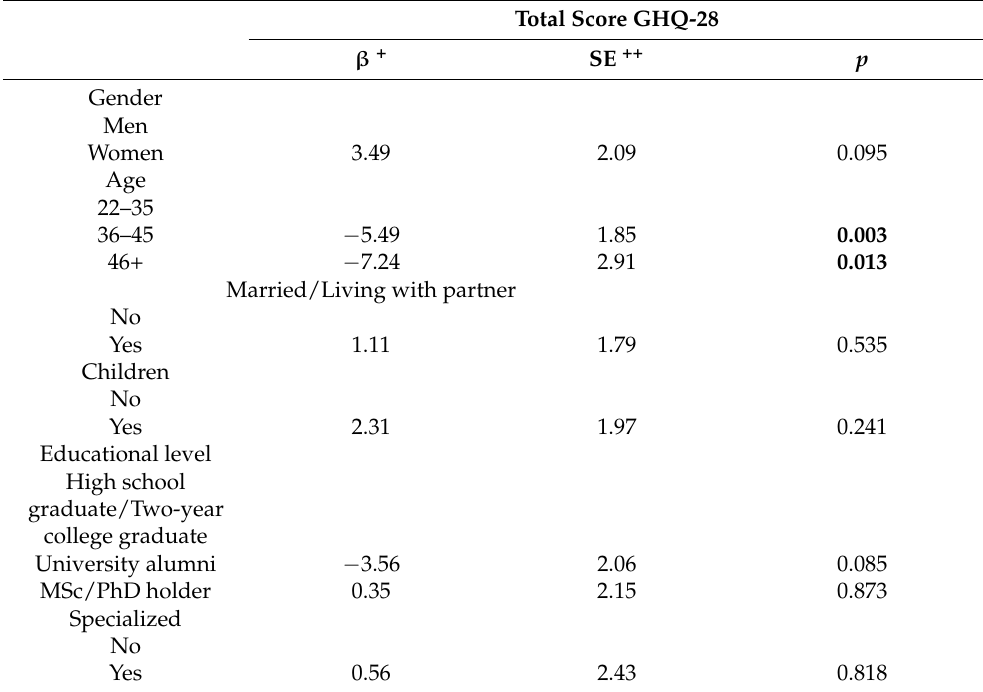
Table 5. Multiple linear regression results with total GHQ-28 score as a dependent